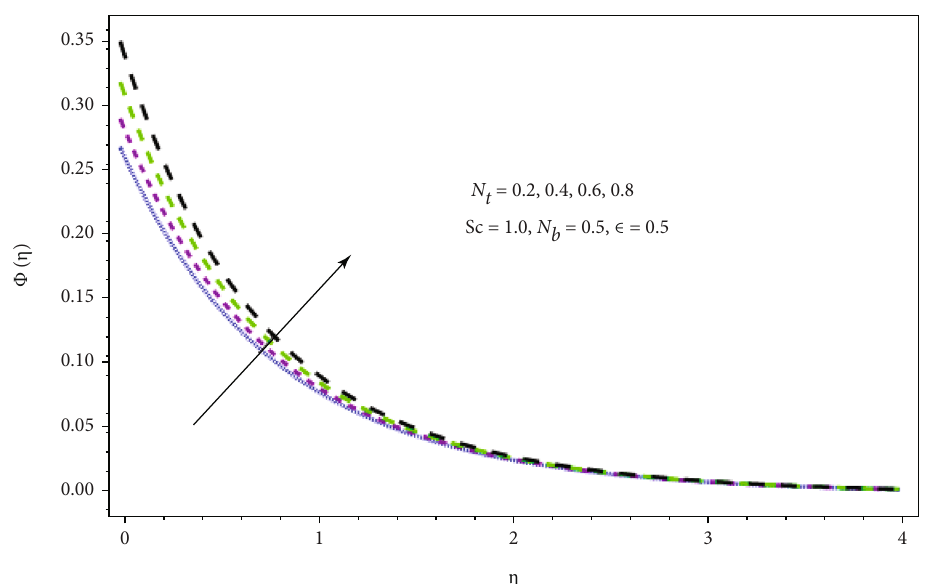
Figure 12: Illustration of the e ff ect of N